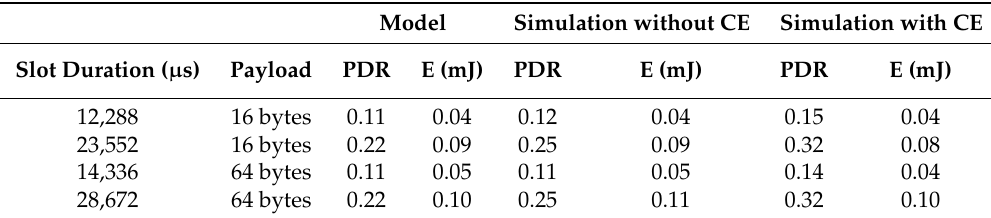
Table 6. Overview for 600 kbps, 16 STAs per slot. Model